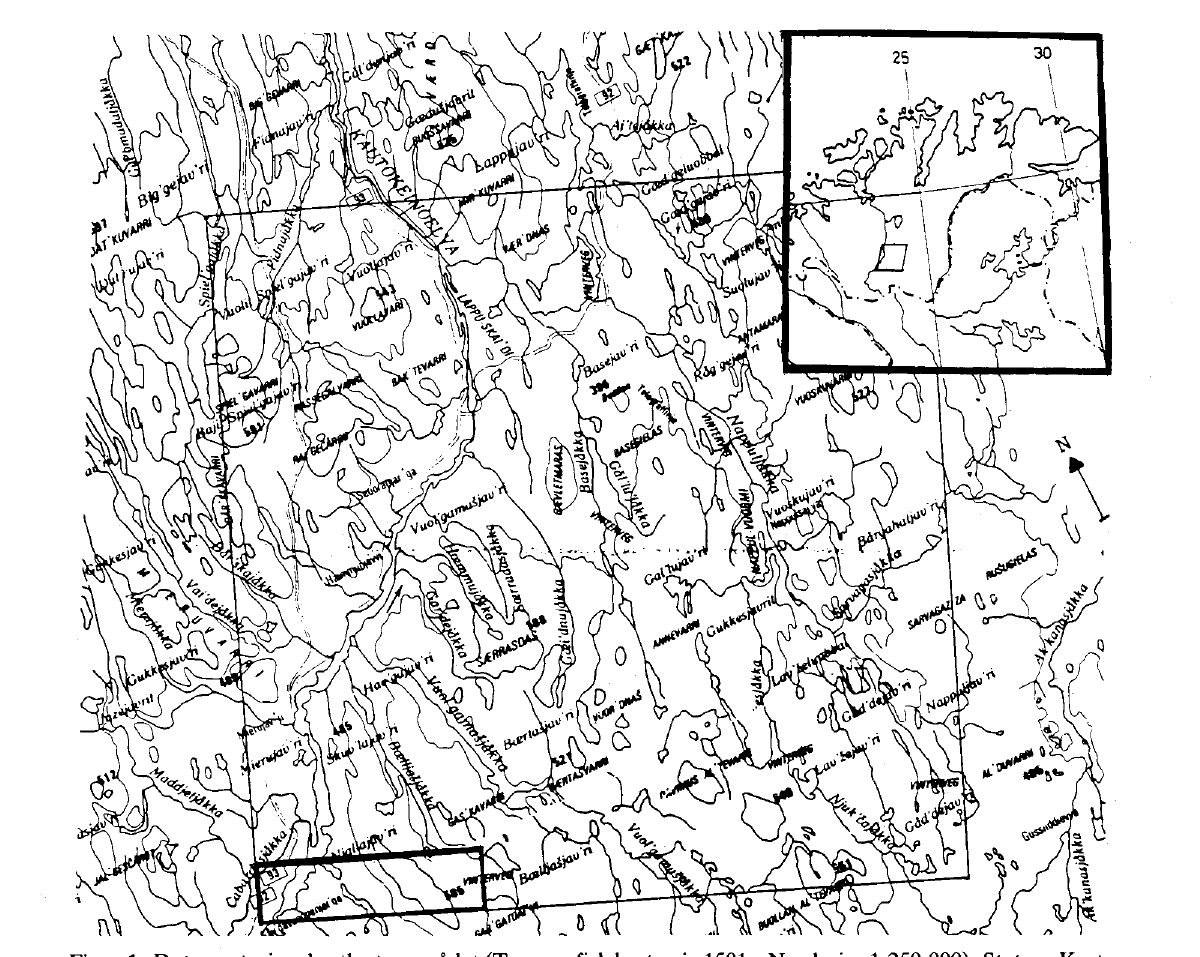
Figur 1. Det vegetasjonskartlagte området (Topografisk kartserie 1501 - Nordreisa 1:250 000), Statens Kart verk). Det lille rektanglet i nedre venstre hjørne representerer området hvor analysen av klassifise- ringsresultatet ble foretatt. Fig. 1. The position of the study area, and the area which is mapped (Topographic map 1501 - Nordreisa 1:250 000). The rectangle in the lower left represents the test area, where the ground truth map is regi-